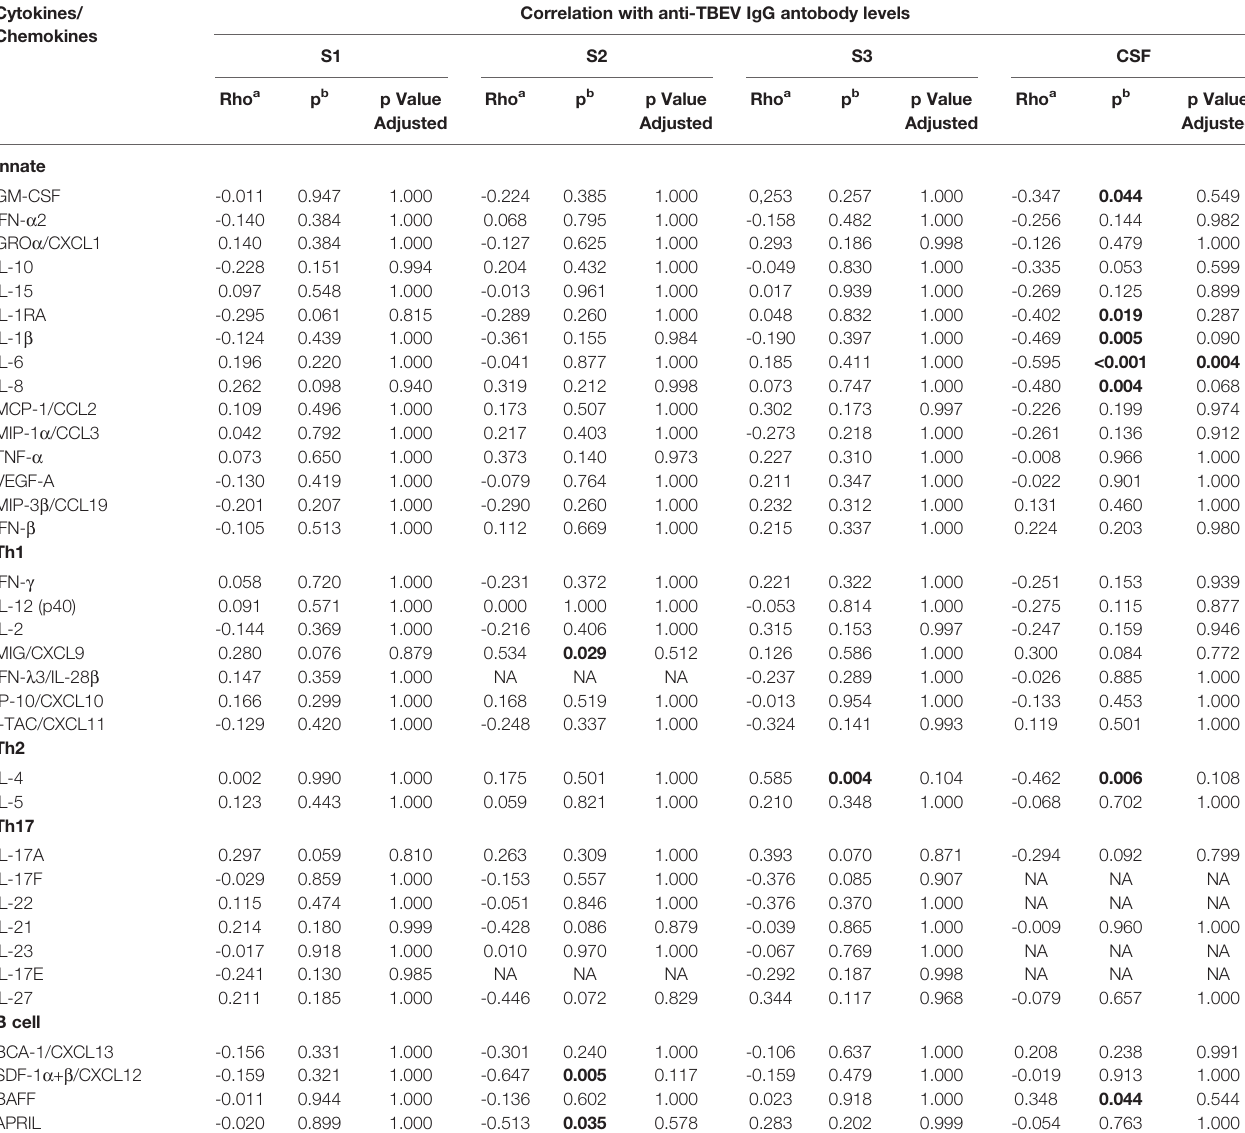
Correlation with anti-TBEV IgG antobody